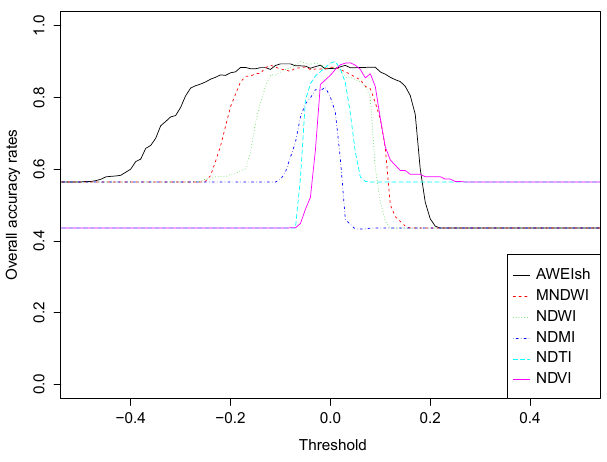
Figure 6. Rate of change of overall accuracy rates for varying thresholds of MNDWI on the Landsat 8 29 March 2013 image for Lake